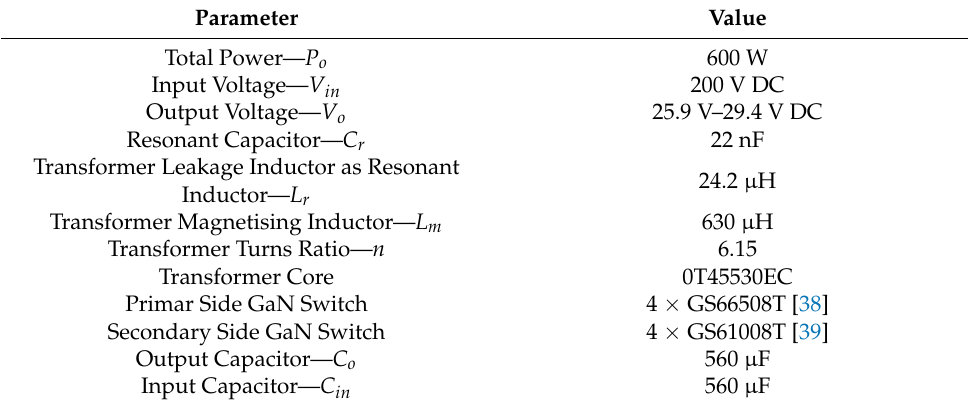
Table 1. Design parameters of LLC resonant converter.